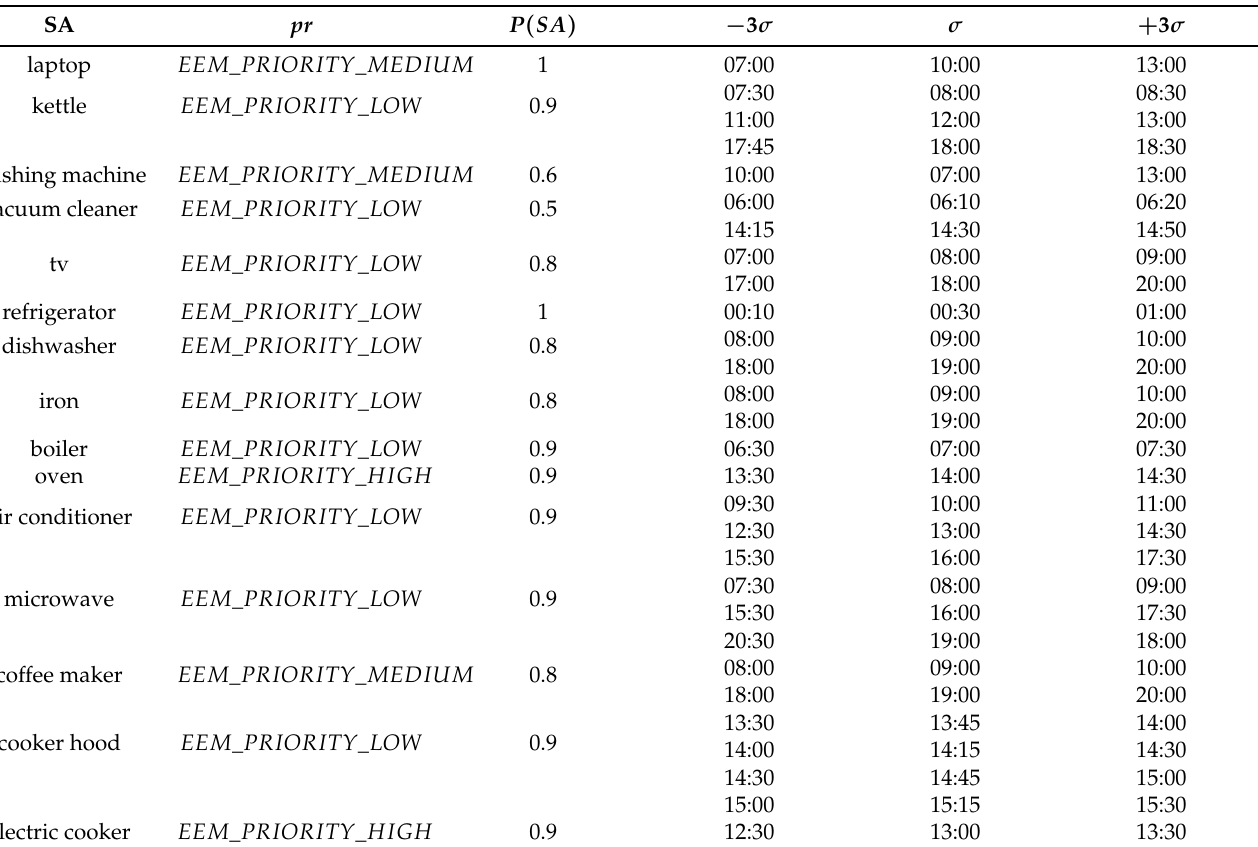
Table 1. Definition of other parameters for